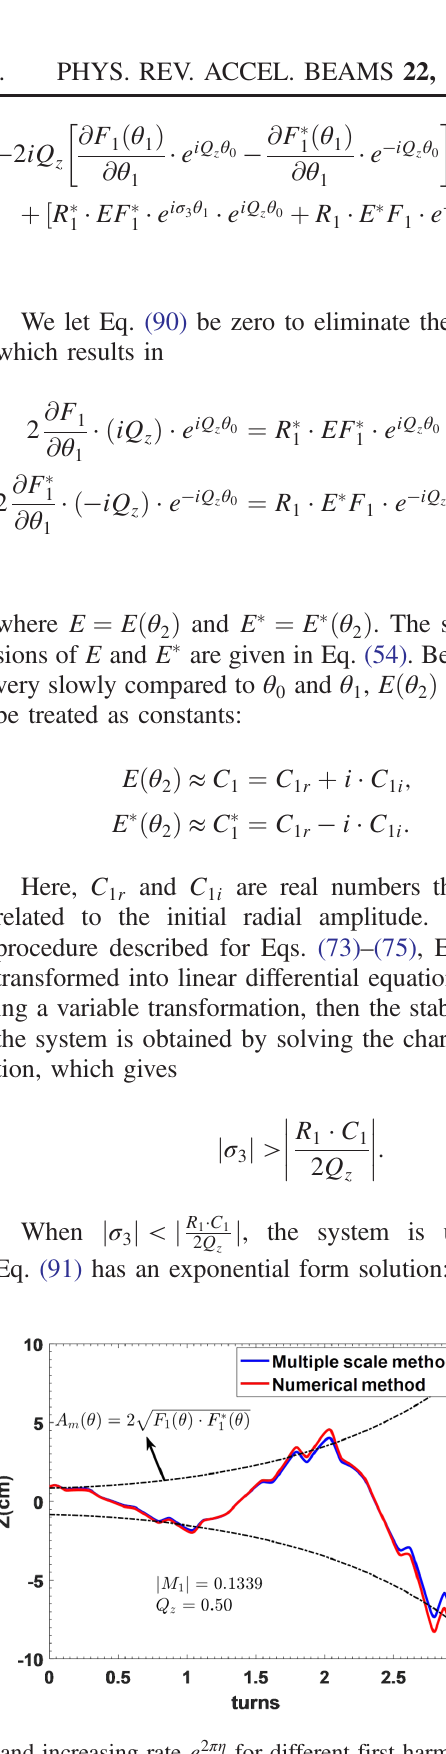
and increasing rate e 2 πη for different first harmonic values near z